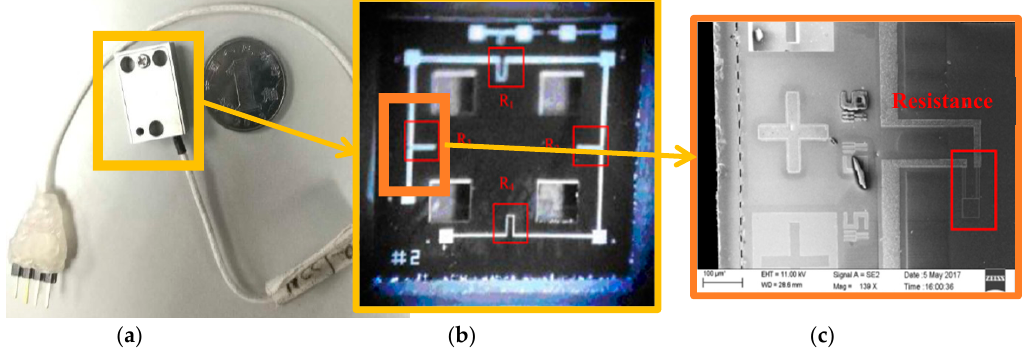
Figure 3. ( a )HGMA overall photo; ( b ) CCD photo; ( c )SEM photo of HGMA. Figure 3. ( a ) HGMA overall photo; ( b ) CCD photo; ( c ) SEM photo of